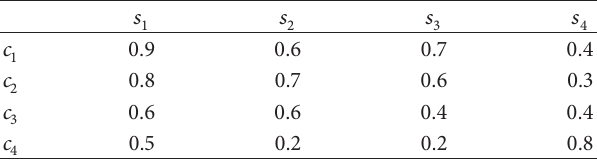
Table 2: Reputations of services evaluated by